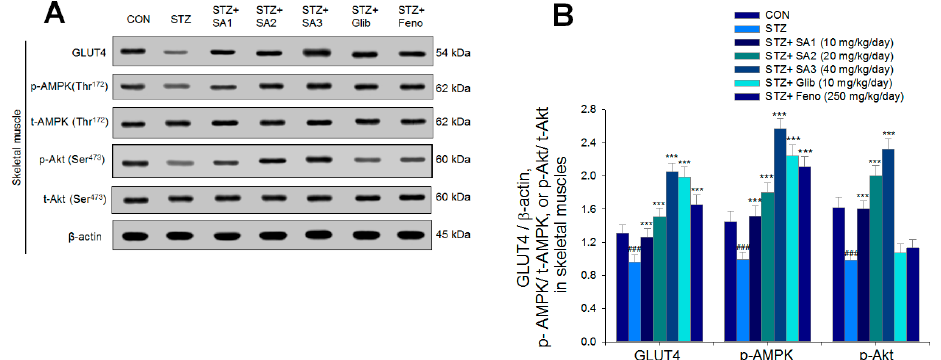
Figure 6. The expression levels of ( A ) membrane GLUT4, p-AMPK (Thr 172 ) / t-AMPK, and p-Akt